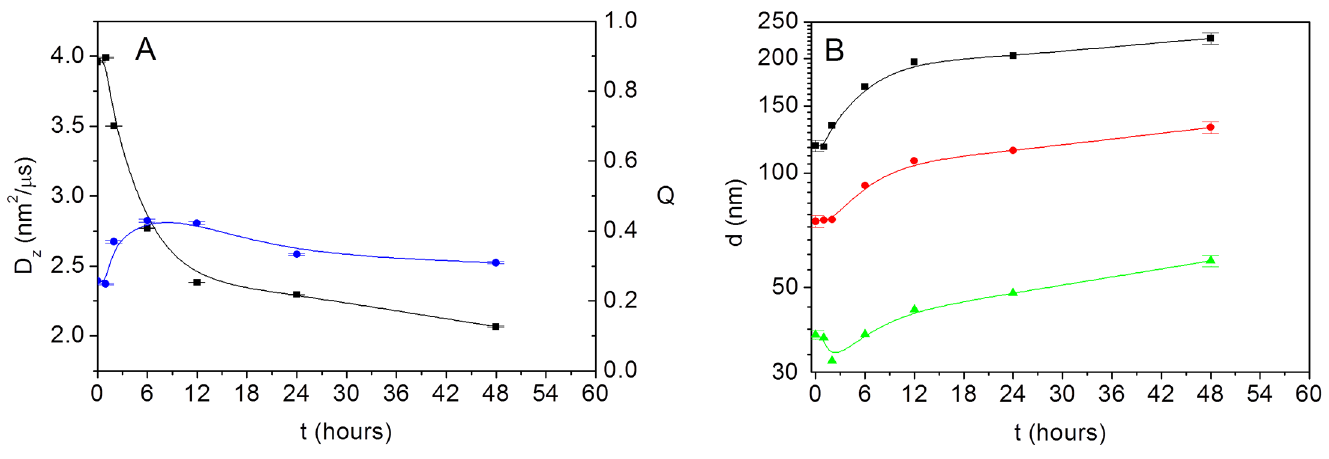
Fig 2. Hydrodynamic properties of virus-like particles. (A) Time evolution of ( ∎ , black) z-average diffusion coefficient (D z = Γ (cid:1) q -2 ) and ( ● , blue) polydispersity (Q = μ 2 (cid:1) Γ -2 ) obtained from the cumulant analysis (the error bars indicate the standard error of the fit). (B) Average sizes d z ( ∎ , black), d w ( ● , red) and d n ( ▲ , green) obtained from the cumulant analysis and Eq (8) (the error bars indicate the standard deviation of three independent measurements for initial and final